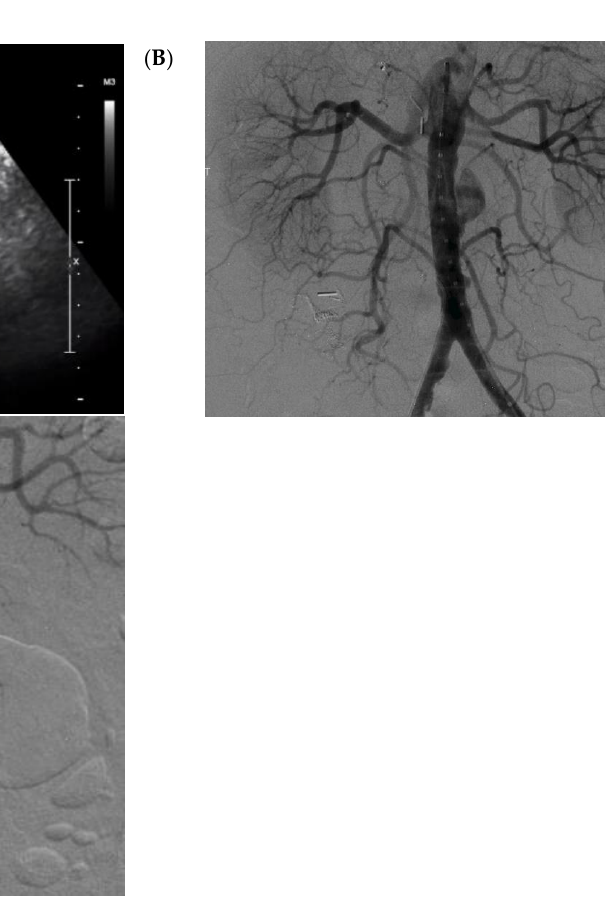
Figure 2. ( A ) Preoperative duplex ultrasound demonstrating rapid expansion of an infra-renal mycotic aortic aneurysm to a maximum diameter of 3.96 cm. ( B ) Anterior posterior intraoperative angiogram demonstrating a mycotic aneurysm. ( C ) Final intraoperative angiogram demonstrating a sealed mycotic aneurysm using an endovascular stent graft.